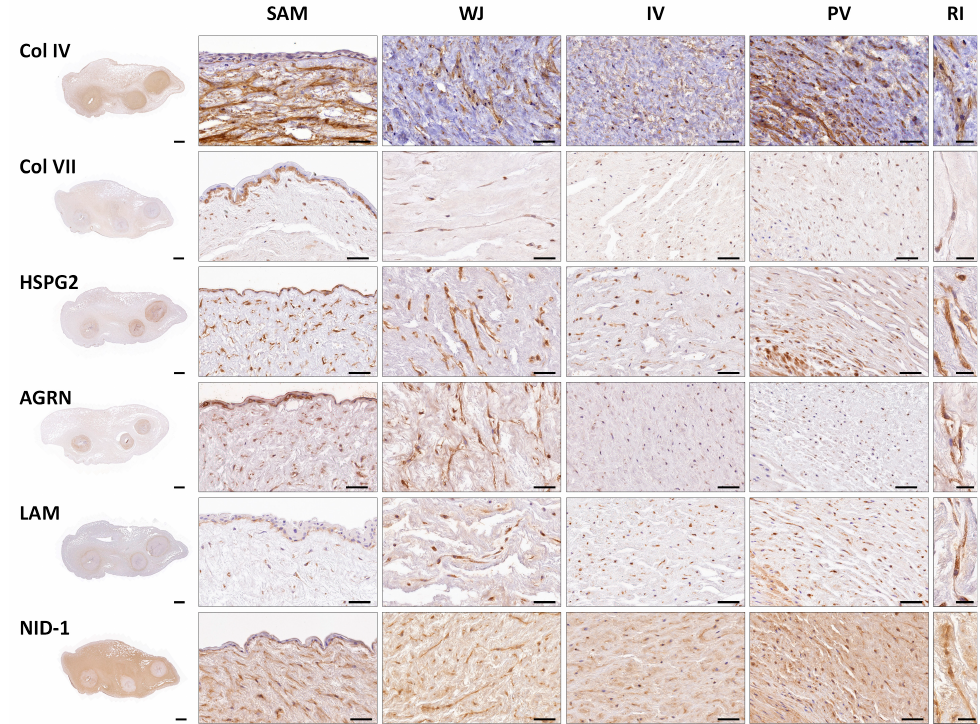
Figure 3. Immunohistochemical analyses of the basement membrane (BM) molecules (collagen type IV and VII (Col IV) (Col VII), proteoglycans heparan sulfate proteoglycan 2 (HSPG2) and agrin (AGRN) and glycoproteins laminin (LAM) and nidogen-1 (NID-1)) in full-term human UCs. Im- munohistochemical methods were applied to analyze complete UC (left) and specific regions; Sub- amnion (SAM); Wharton’s Jelly (WJ); intervascular (IV) and perivascular (PV). Representative im- ages (RI) at higher magnification are shown on the right. Brown color: immunohistochemical posi- tive reaction and slight blue: hematoxylin contrast. Scale bar: 1000 µm (complete UC), 50 µm (spe- cific UC regions) and 25 µm (RI).